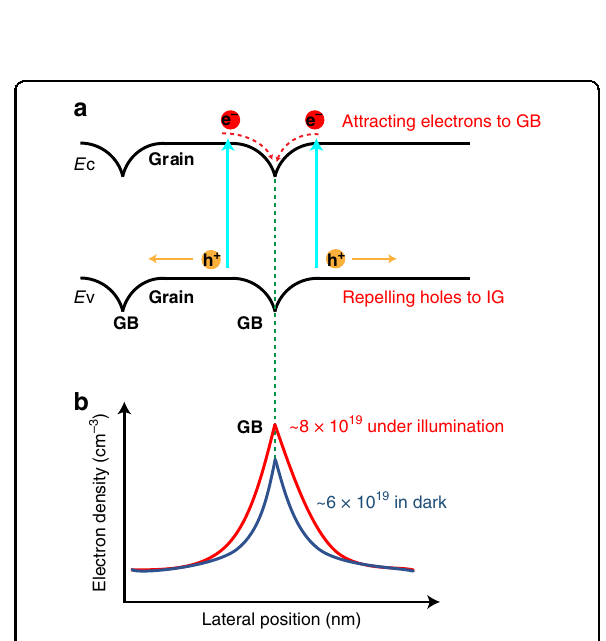
Fig. 5 Physical picture illustration of the electron accumulations at GBs. a Schematic illustration of the band alignment between IGs and GBs. The yellow/red solid circles indicate holes/electrons, and the yellow/red arrows show their direction of movement. E C and E V stand for the conduction band bottom and the valance band top, respectively. b Schematic illustration of electron density around the GB with and without additional light illumination. The downward band bending at the GB results in an accumulation of electrons in the GB region with electron density increases from 6 × 10 19 cm − 3 to 8 × 10 19 cm − 3 (solid red line) under 532 nm illumination